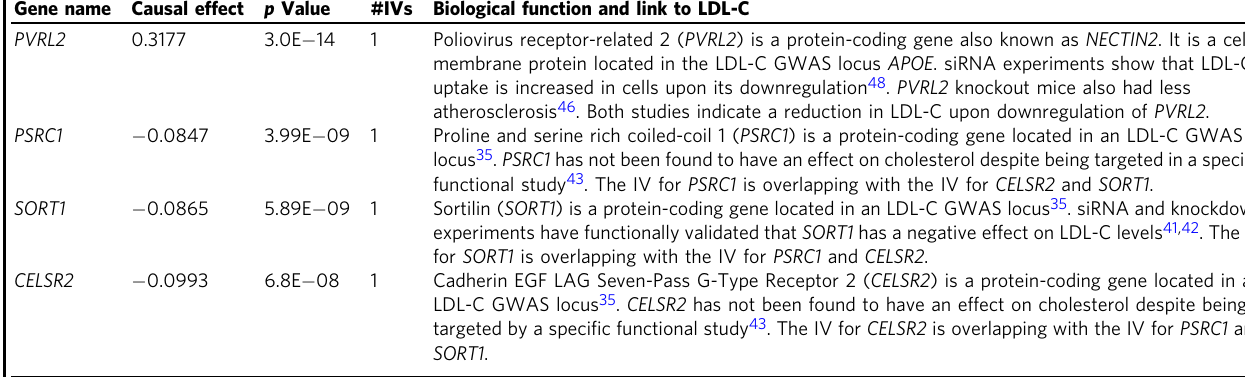
Table 3 MR-link results using GTEx liver eQTLs.